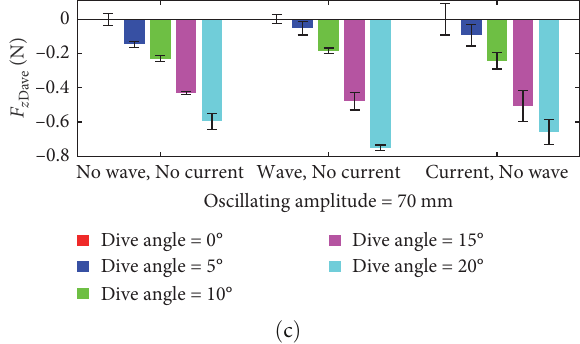
F IGURE 10: F xD ; F yD , and F zD with various dive angle over environmental